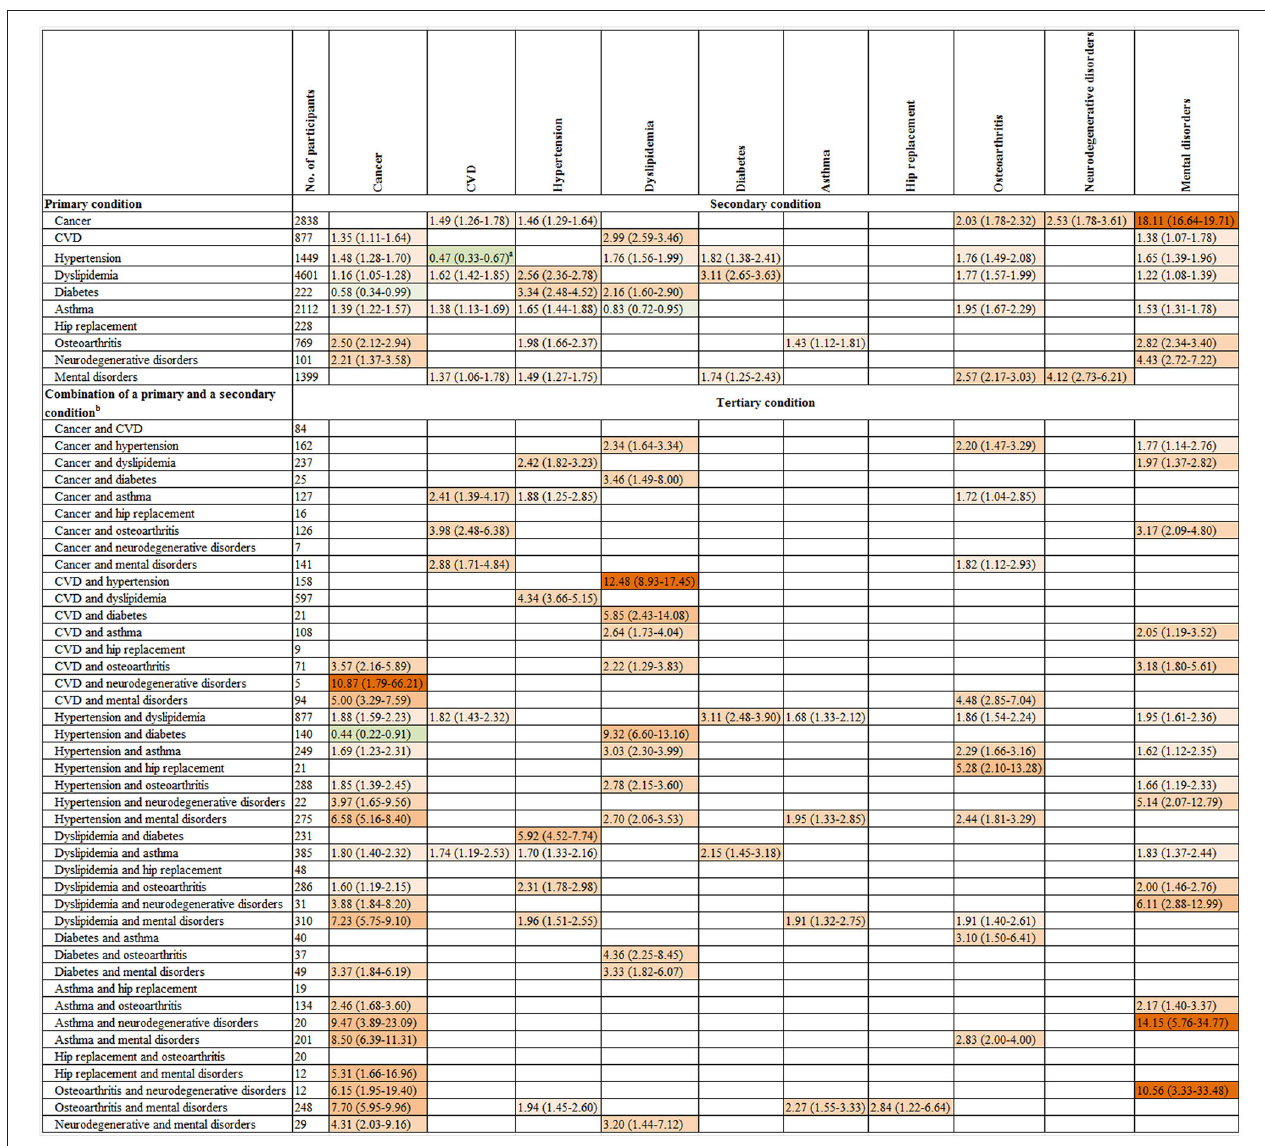
FIGURE 4 | The association of the onset of a primary condition or combinations of the onset of a primary and a secondary condition with progression to a subsequent condition. CI, confidence interval; CVD, cardiovascular disease; RR, relative risk. The graph shows the relative risk (95% CI) for progression to a secondary condition in the top row associated with a primary condition in the left column as well as the relative risk for progression to a tertiary condition in the top row associated with combinations of two existing conditions in the left column. The number of participants listed represents those with a primary condition or a combination of a primary and a secondary condition in the left column. Participants who were free of any of 10 chronic conditions at baseline were the reference for all comparisons. The associations of the onsets of each of 10 primary conditions with the progression to each of 10 secondary conditions and each of 44 combinations of a primary and a secondary condition with the progression to each of 10 tertiary conditions were examined. Given the multiple comparisons, only significant associations with the false discovery rate < 0.05 were presented in this figure. Poisson regression was used to estimate the relative risk that adjusted for age, gender, income, education, body mass index, and health insurance. Green and red colors indicate inverse and positive association, respectively, and color intensity is proportional to the size of relative risks. a Further analysis showed the multivariate-adjusted RR (95% CI) for progression to CVD as the secondary condition was 6.27 (5.50–7.15) in individuals with hypertension as the primary condition after adjustment for age, gender, income, education, body mass index, and health insurance when the interplay analysis was restricted to these two conditions. b Two combinations with 1–4 participants are not present in this figure due to participant confidentiality reasons. Neither of these combinations was associated with the onset of any of the tertiary conditions. The results for quaternary condition are not shown in Figure 4 , as 93 out of 112 combinations of the first three conditions has 10 or fewer participants resulting in low statistical power to test significant associations for these